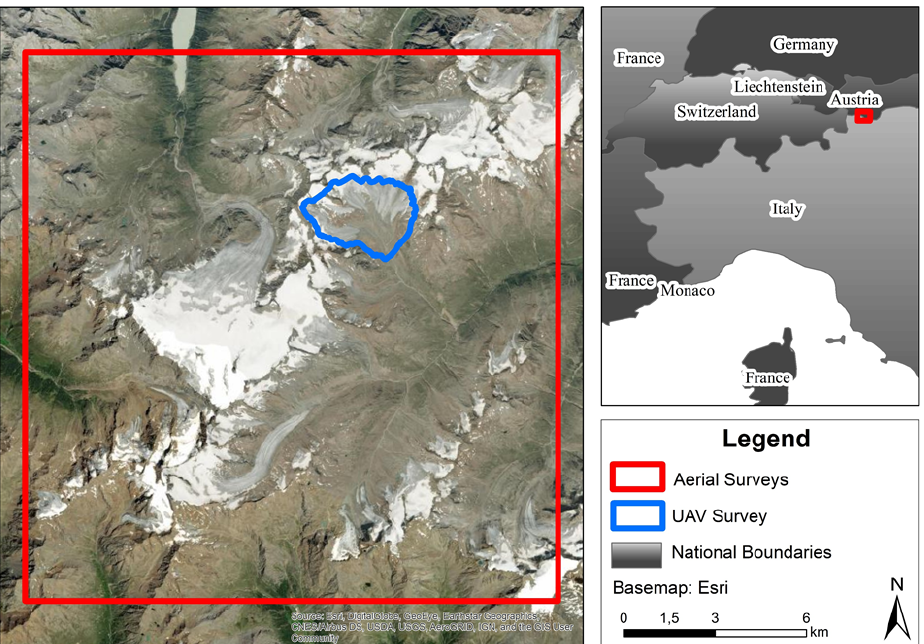
Figure 1. Study site in the Ötztal Alps. Red shows the area covered by aerial surveys; blue shows the area of the Vernagtferner covered by the UAV survey. Image source: ESRI (2020). Table 1. Overview of the aerial data